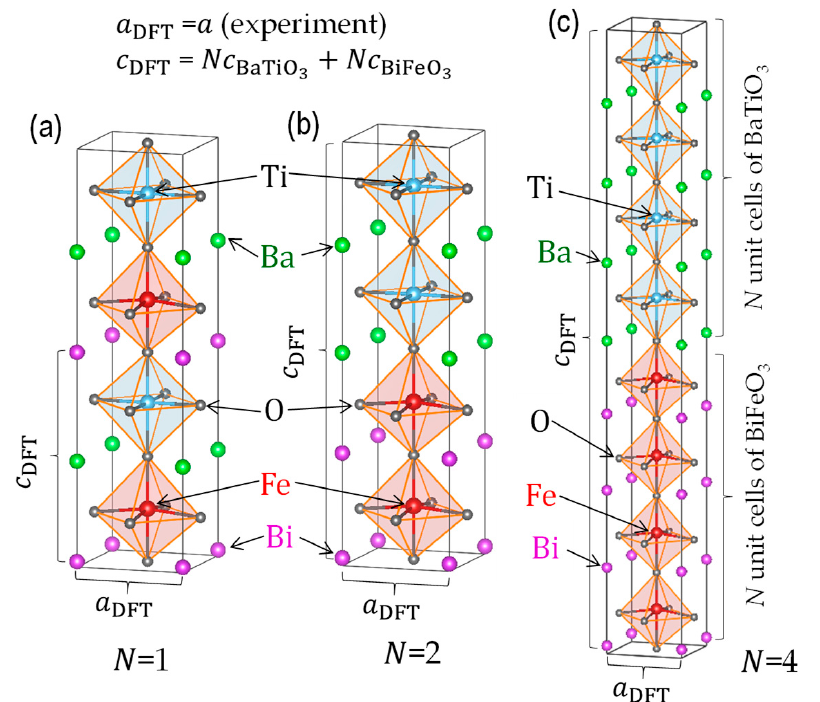
Figure 2. Crystal structures of the superlattice cells with ( a ) N = 1, ( b ) N = 2, and ( c ) N = 4 obtained from the structural optimizations by DFT calculations, where BiFeO 3 is employed instead of Mn- BiFeO 3 for simplicity. The in-plane lattice parameter a DFT of the superlattice cell was fixed at the experiment: a (experiment) = 0.3985 nm. The out-of-plane lattice parameter c DFT of the superlattice cell was determined from the cell volume obtained by geometrical optimizations in our preceding calculations of BiFeO 3 and BaTiO 3 in tetragonal P 4 mm symmetry.